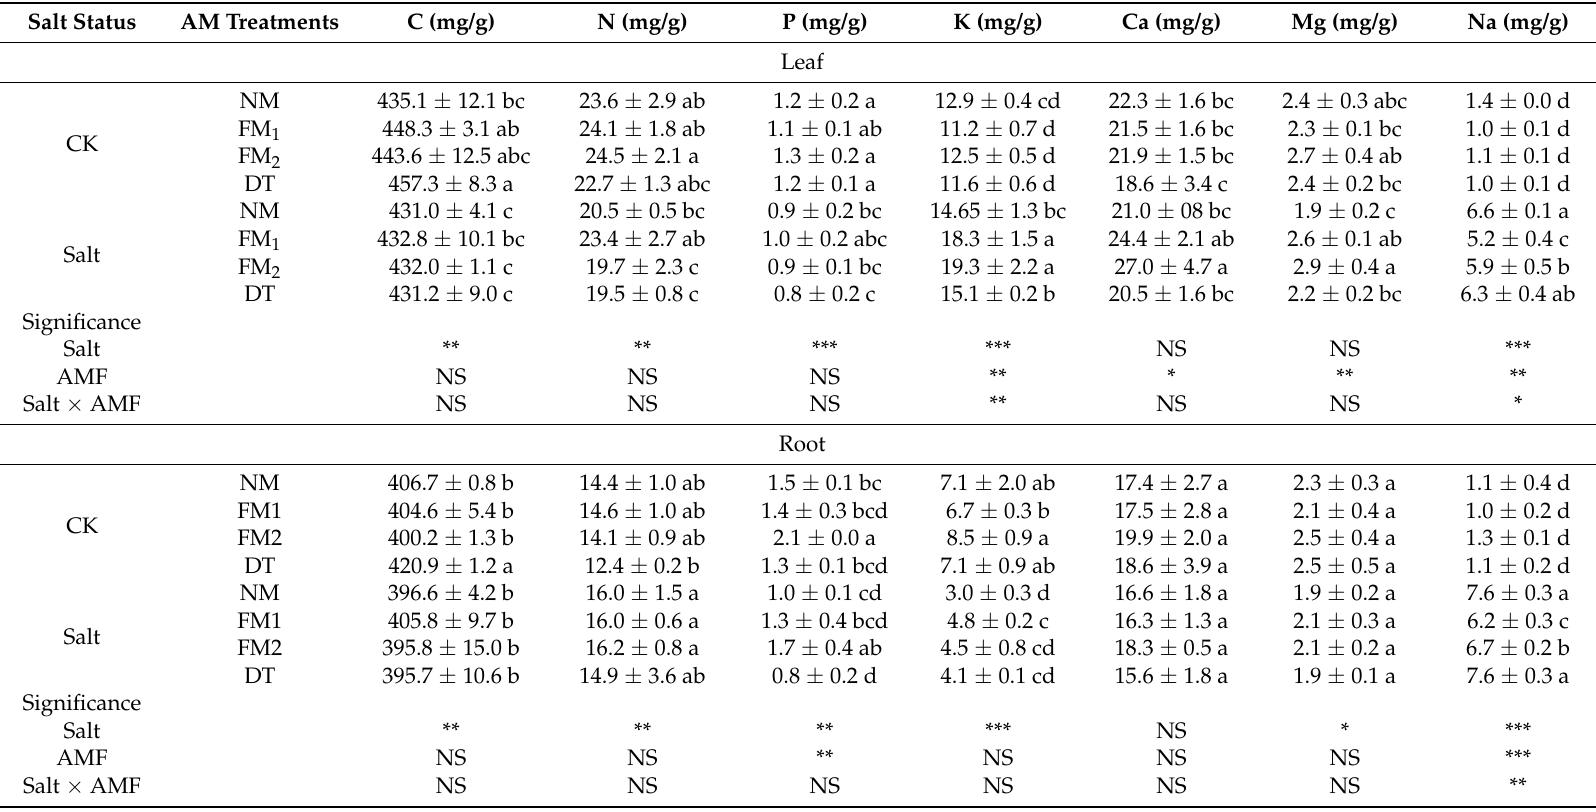
Table 2. Effects of salt and AMF inoculation on leaf and root nutrient